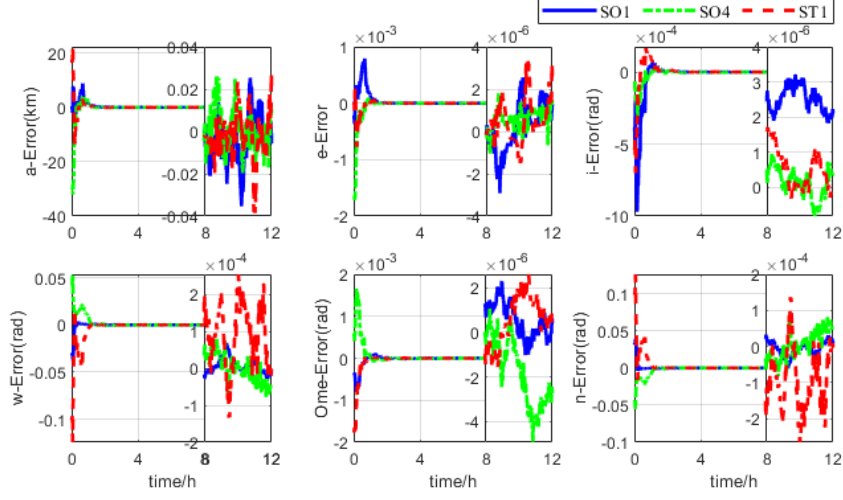
Figure 8. Orbits in general orbit configuration case with an additional observer.